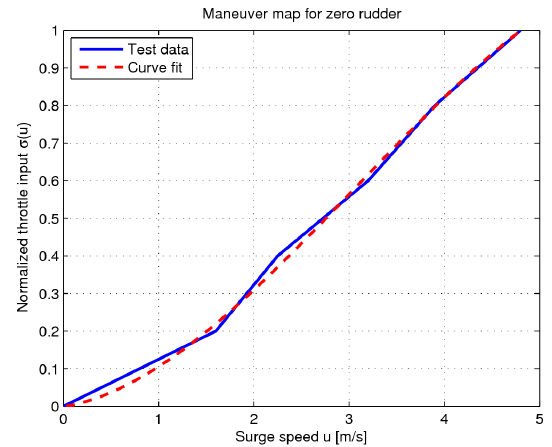
Figure 8: The maneuver map obtained through steady- state USV